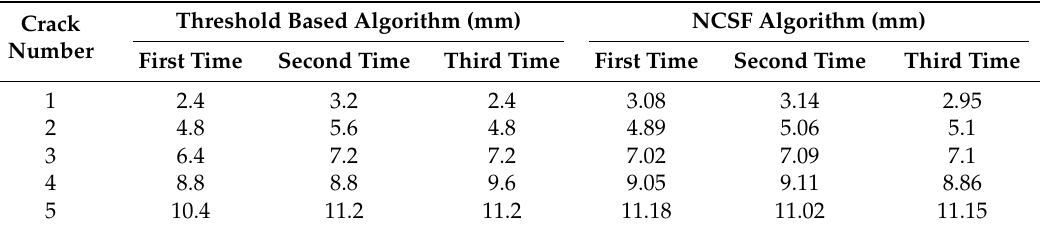
Table 2. Quantitative results of specimen